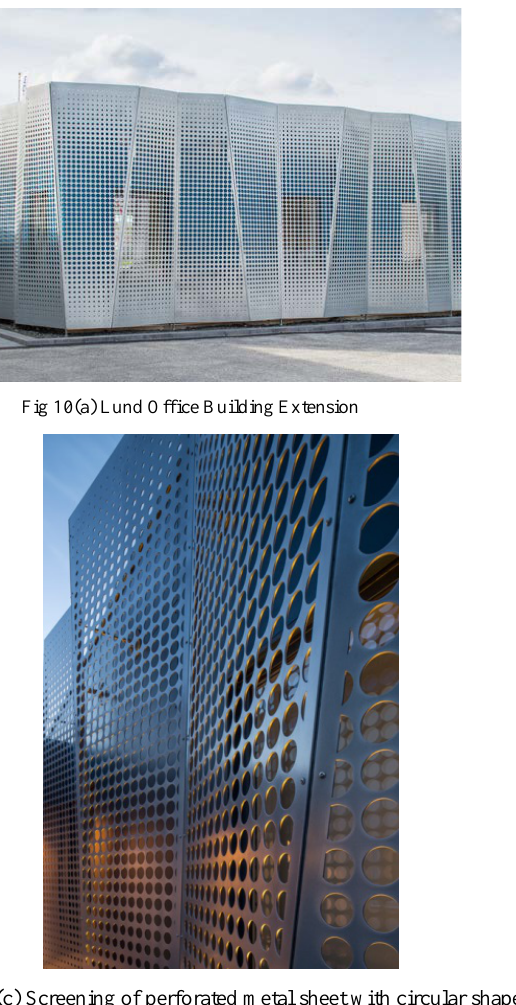
Fig 10(c) Screening of perforated metal sheet with circular shapes (dezeen.com) Fig 10(d) Offices